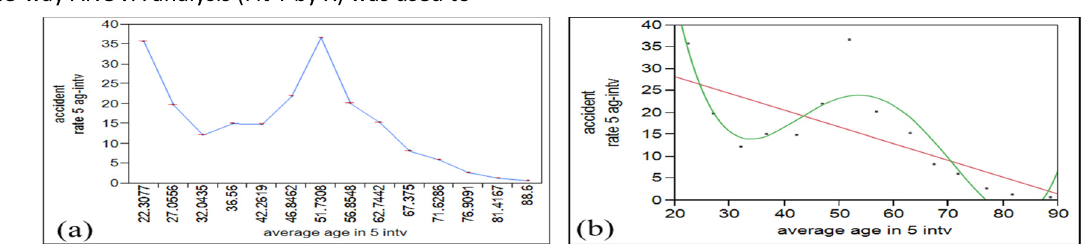
FIG.1: ACCIDENT RATE VERSES AGE (a) CONNECTING THE MEAN ACCIDENT (b) LINEAR FIT LINE AND NONLINEAR QUARTIC POLYNOMIALS